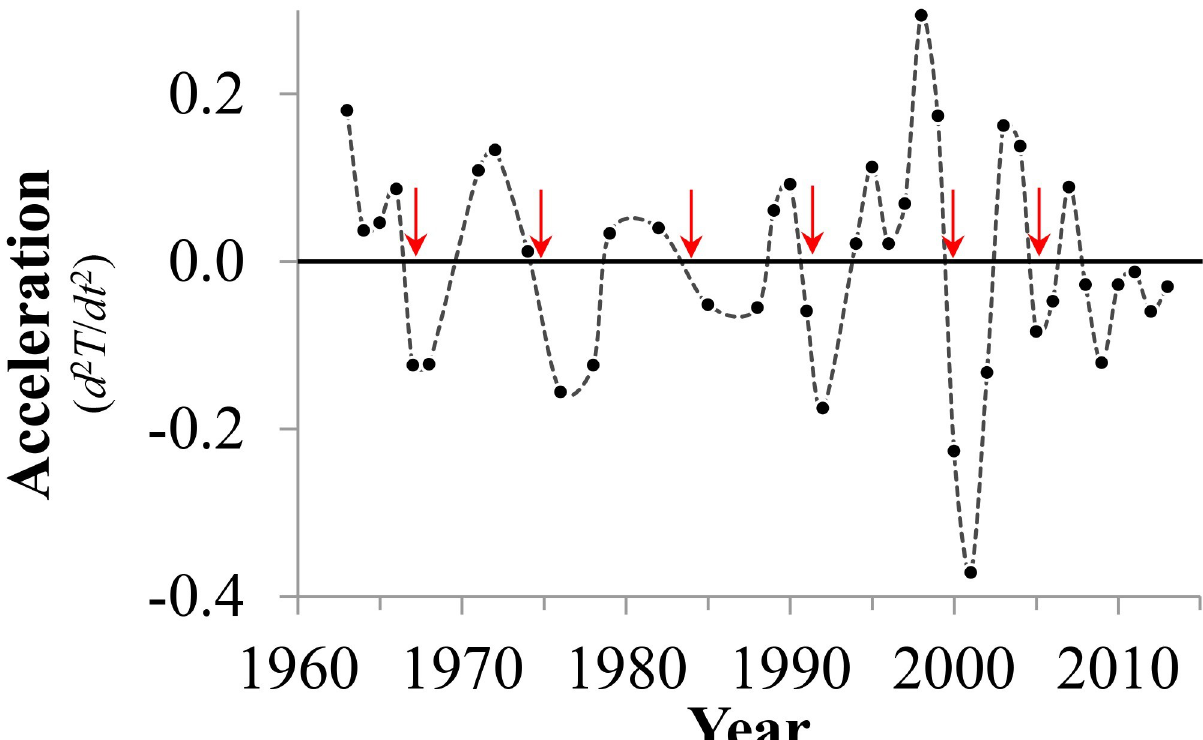
Fig 5. Approximated second derivative exhibits complex acceleration and deceleration patterns in the data. Arrows indicate inflection points where growth rates decline.